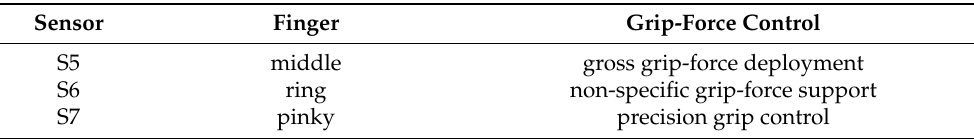
Table 2. Functionally relevant sensors (S5, S6, S7) for the controlled manipulation of the cylindrical robotic handles. Output measures for these sensors from the expert’s and the novice’s first and last task sessions with the dominant hand were compared to bring to the fore proficiency-specific differences. Sensor Finger Grip-Force Control S5 middle gross grip-force deployment S6 ring non-specific grip-force support S7 pinky precision grip